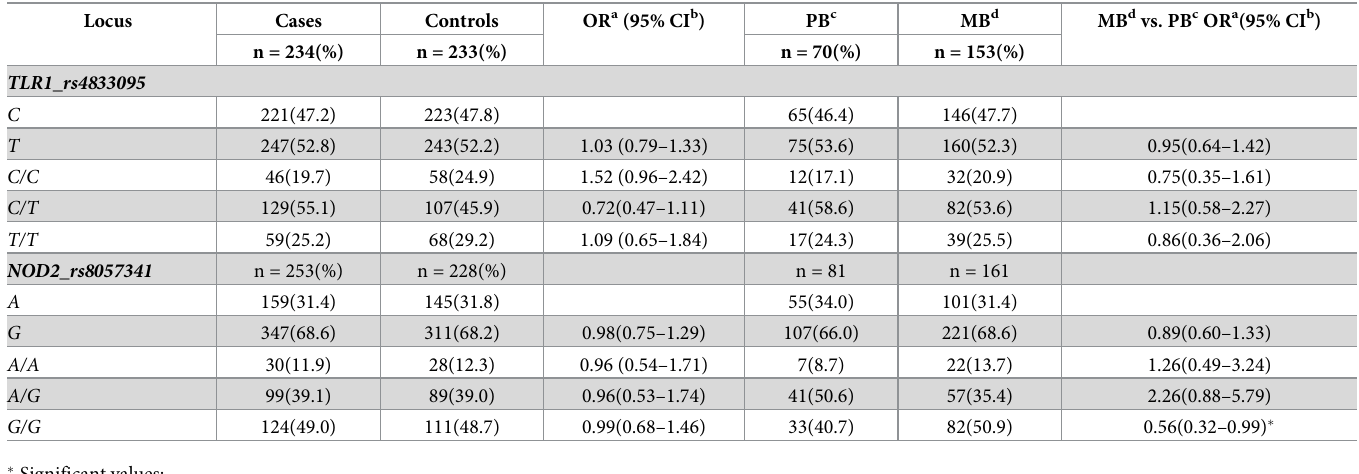
Table 1. Allelic and genotypic frequencies in cases, according to operational classification, and controls.